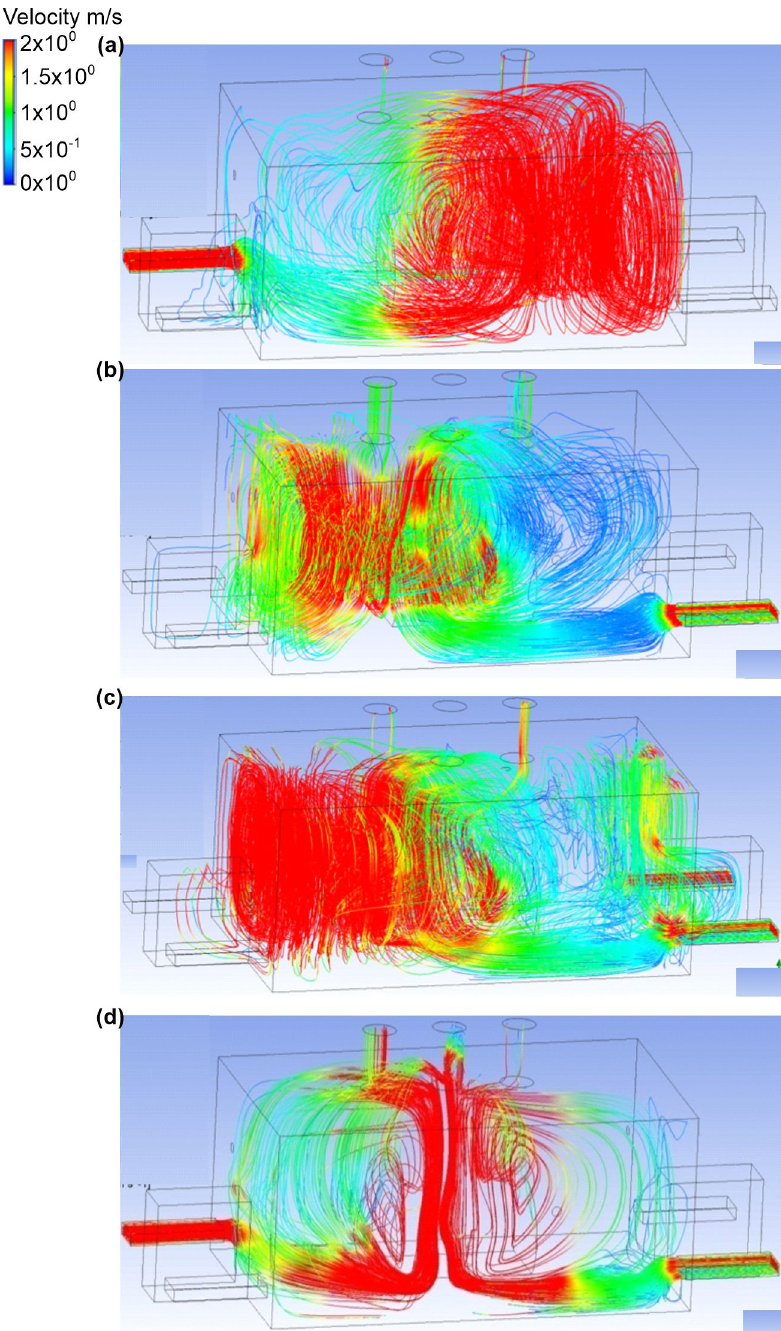
Figure 11. Velocity distribution in the engine room for: ( a ) scenario A, ( b ) scenario B, ( c ) scenario C, and ( d ) scenario D. and ( d ) scenario